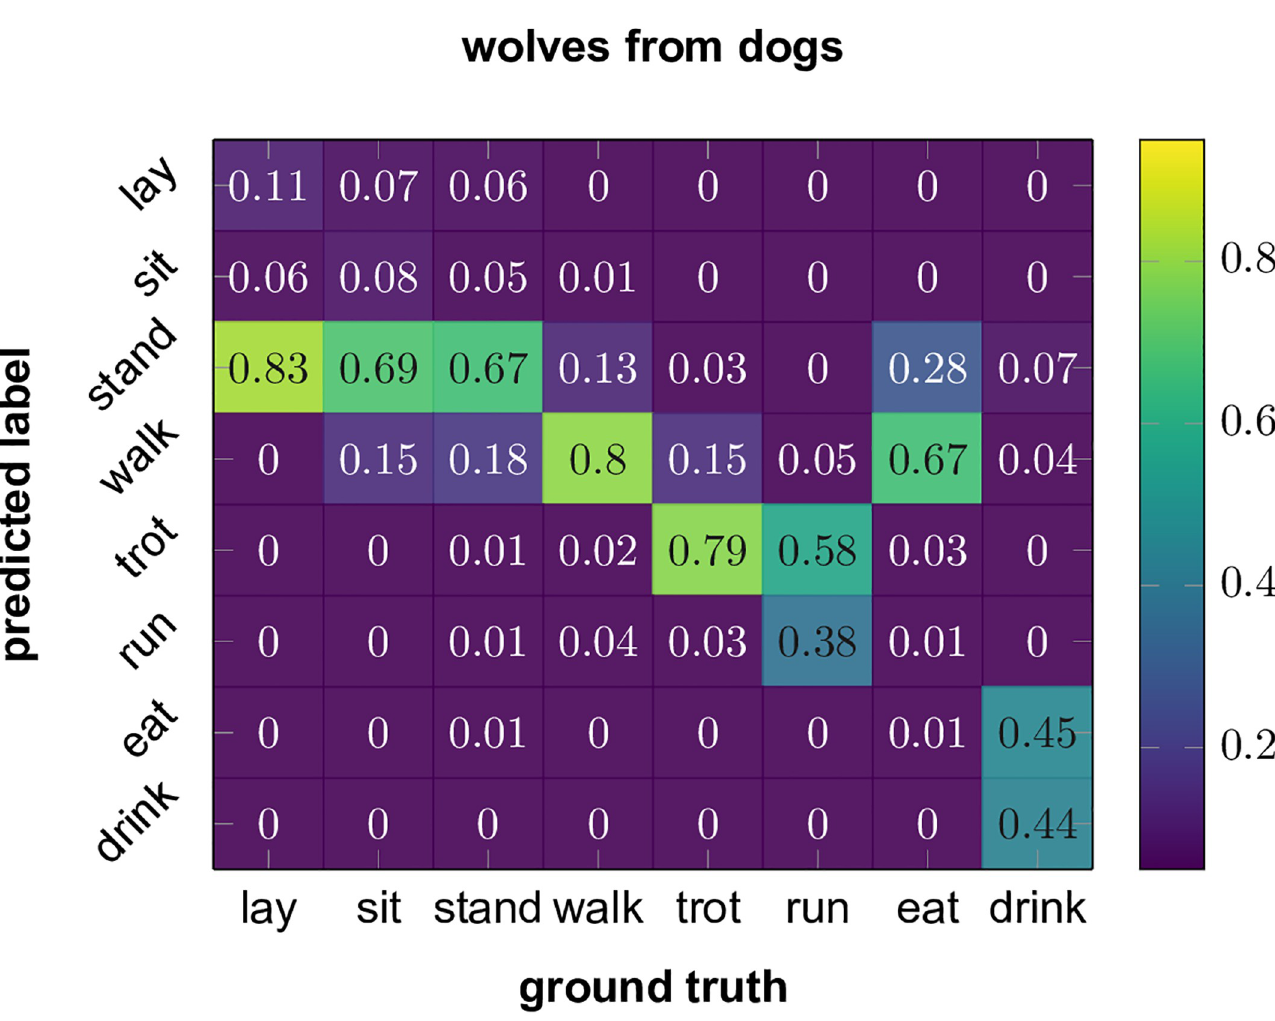
Fig 4. Confusion matrix between dogs and wolves. Using the combined data of dogs to predict wolves. Differentiating between the passive states (sit, lay, stand) is problematic, but they can be combined with great accuracy. Walk and trot are easily distinguishable, while trot and run are often mixed up, the data suggest wolves may in general run faster than dogs. Feeding behaviour seems to be the most problematic, although the drinking of wolves is practically always considered as feeding